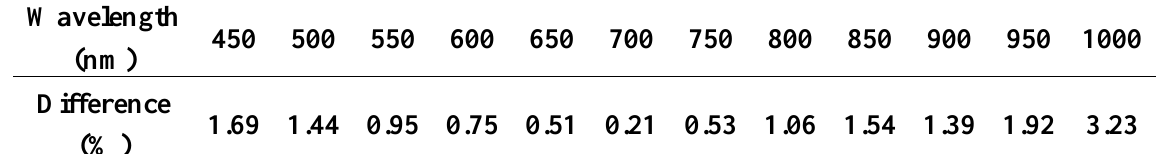
Table 3 . Maximum percentage differences between second-order polynomial functions to calculate the Bidirectional Reflectance Factors R goniometers. Light source is at nadir position and sensor at 75°